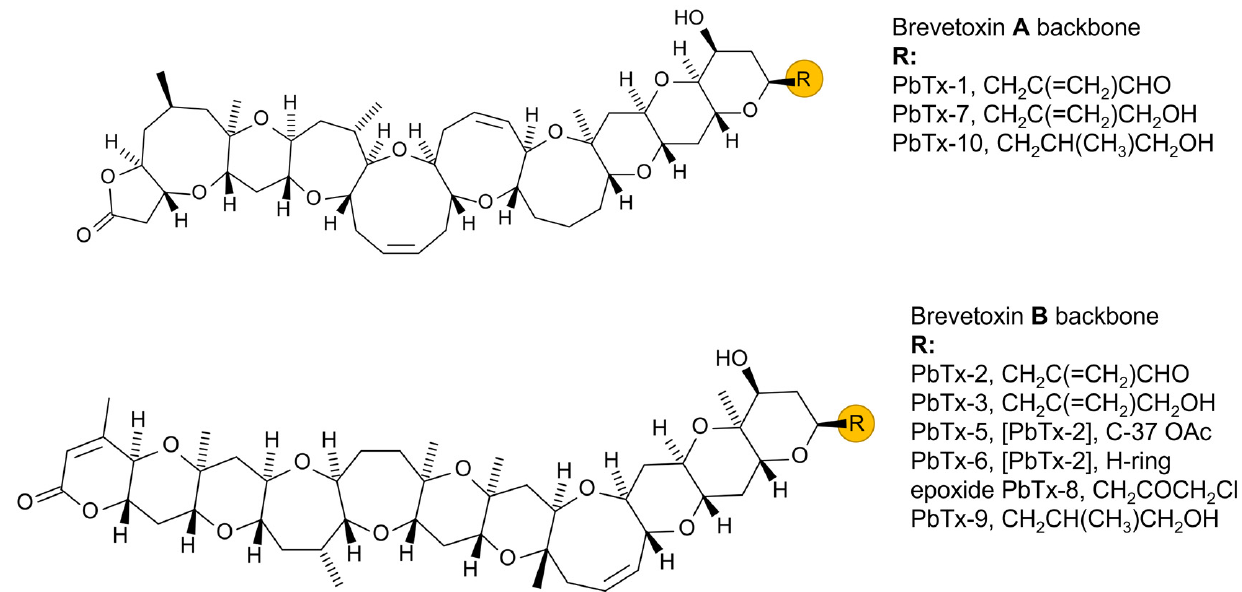
Figure 5. Brevetoxin structures. Modified from [88].